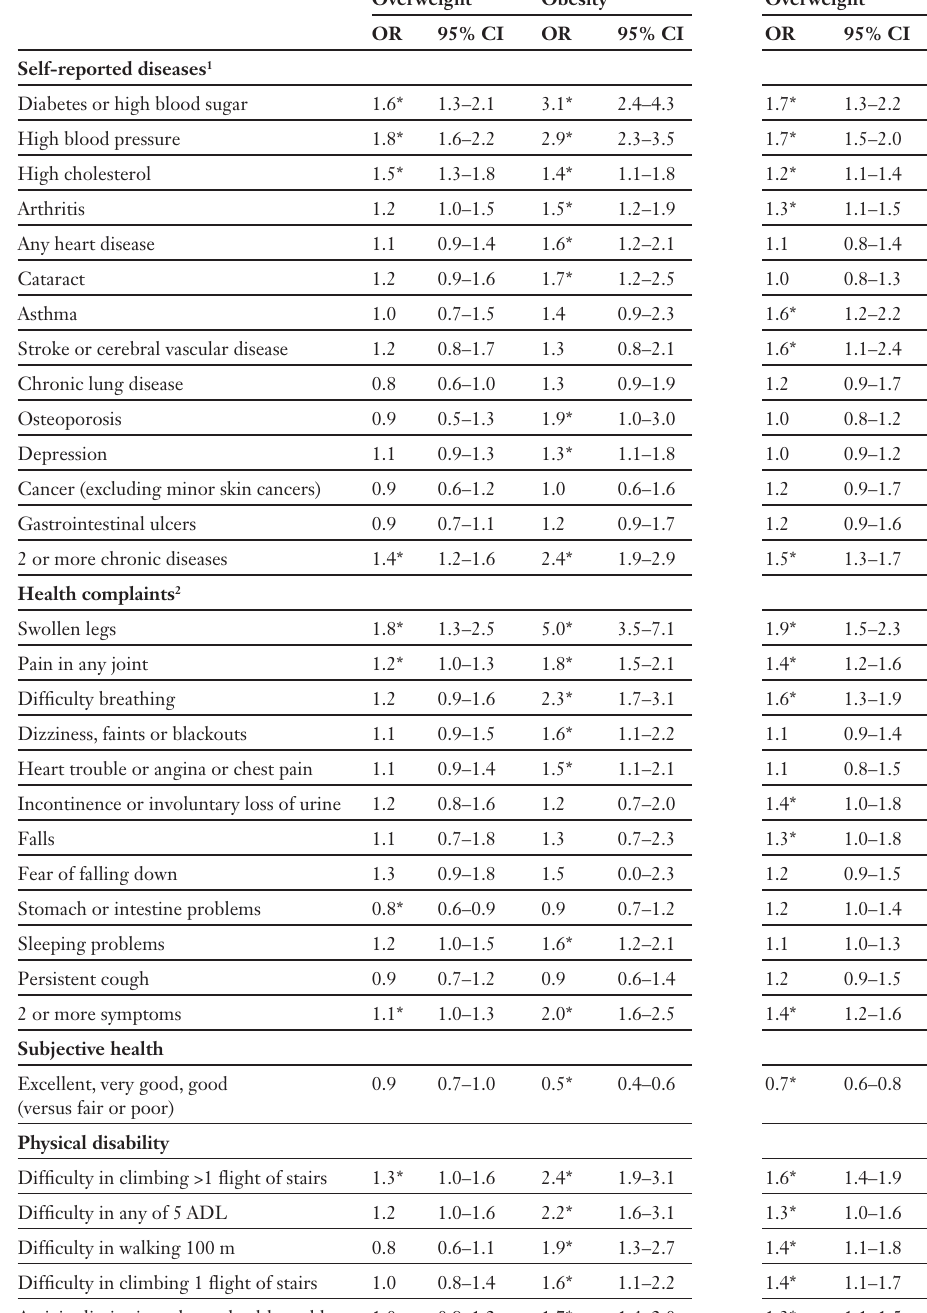
Table 3 Adjusted odds ratios† (95% CI) for self-re- ported diseases, health complaints, subjective health and physical disability, according to BMI (ref- erence = normal weight